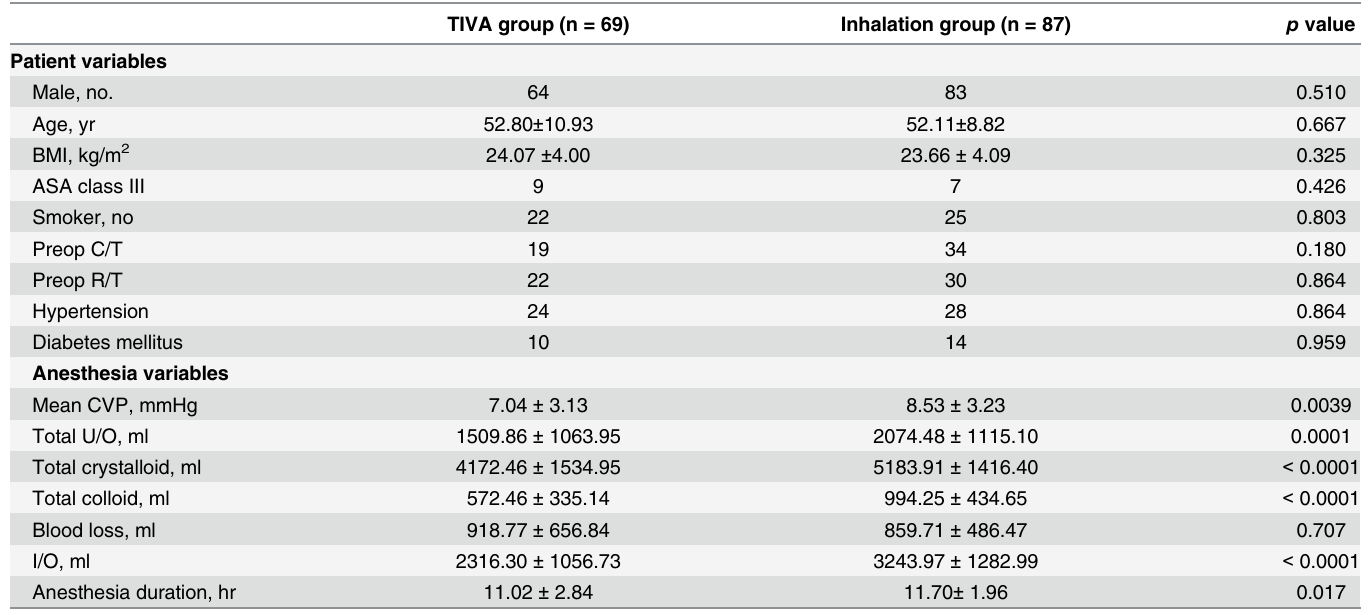
Table 2. Comparison between the TIVA and inhalation groups.